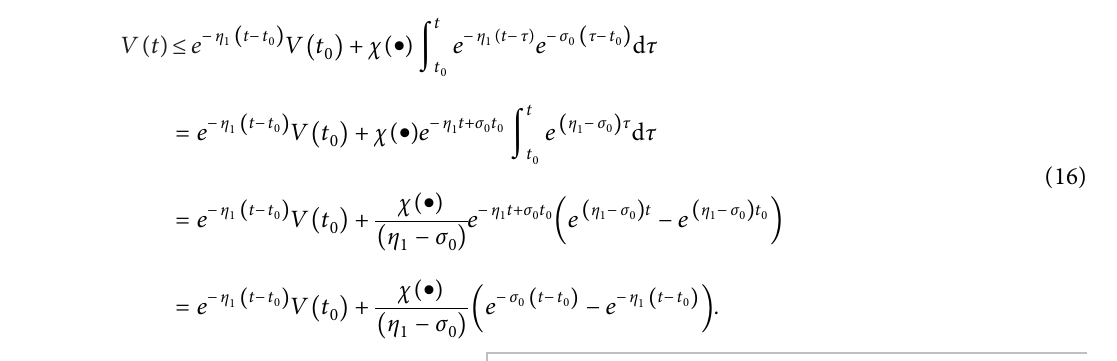
Figure 9: Comparative tracking errors of multifrequency sinusoidal